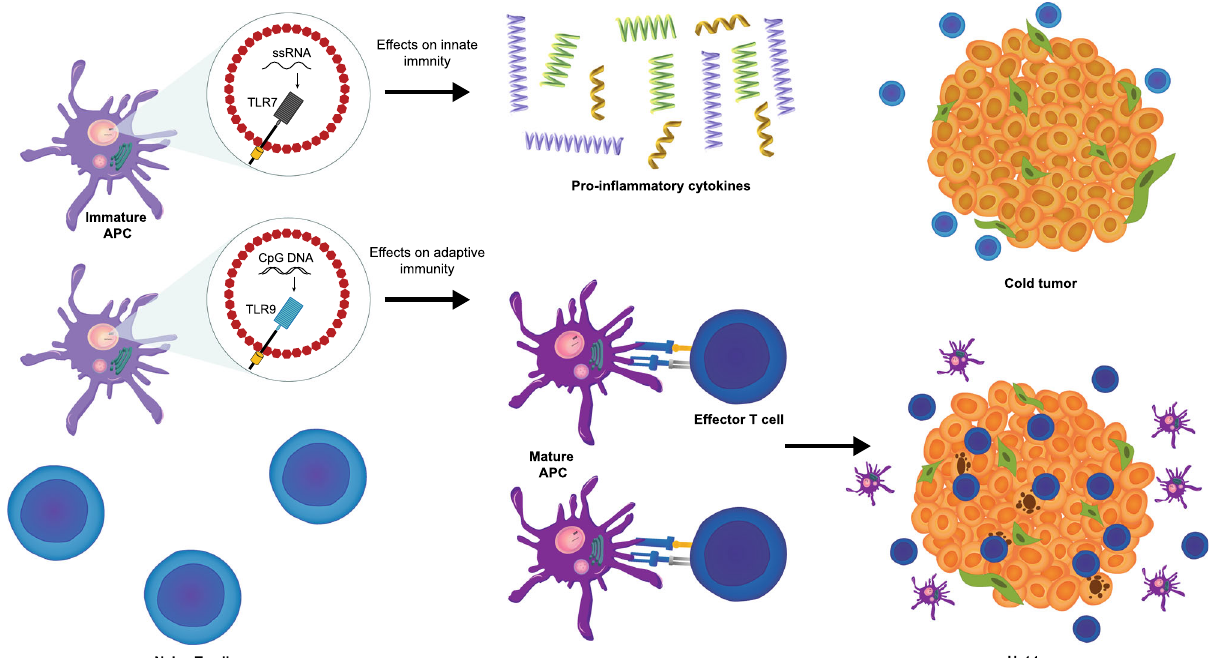
Fig. 2 Hypothesized mechanism for synergism between TLR agonists and immune checkpoint inhibitors in enhancing antitumor immunity. TLRs are involved in both innate and adaptive immunity. It is hypothesized that the anti-tumor effects of TLR agonists are